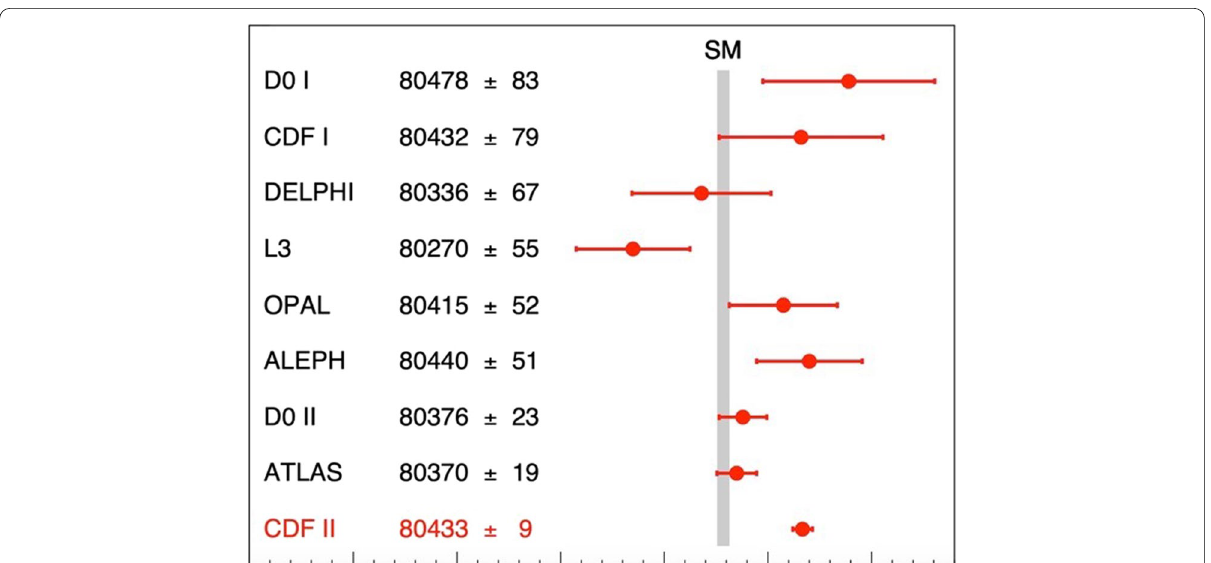
Fig. 1 Tension with the value expected based on the SM. The horizontal bars denote the uncertainty of the various measurements